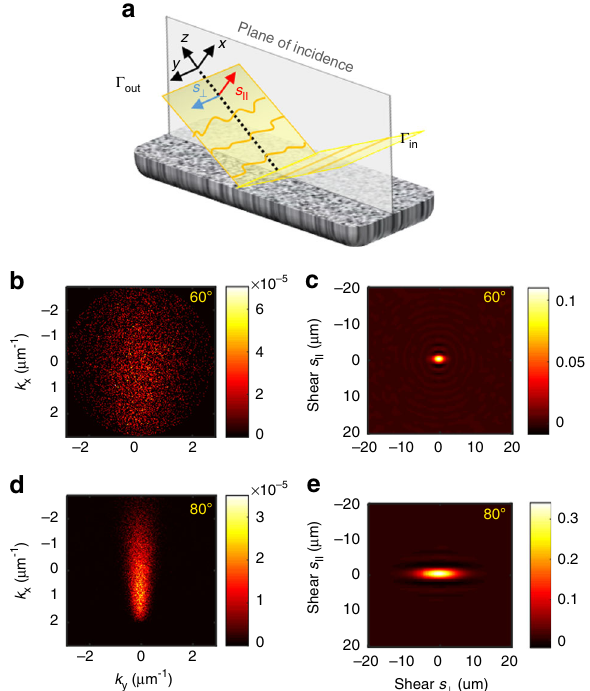
Fig. 2 Anisotropic transfer of spatial coherence. a Schematic representation of the fi eld re fl ected from a diffusive wall and its SCF assessed for in-plane s s ⊥ shears. b , d Angular distributions of speci fi c intensity || and out-of-plane corresponding to 60° and 80° angle of incidence, respectively.